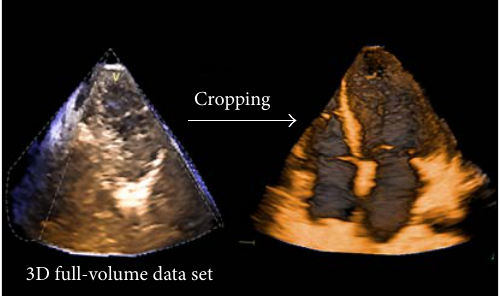
Figure 5: Cropping allows obtaining stereoscopic images of the cardiac structures contained in a pyramidal 3D data set.